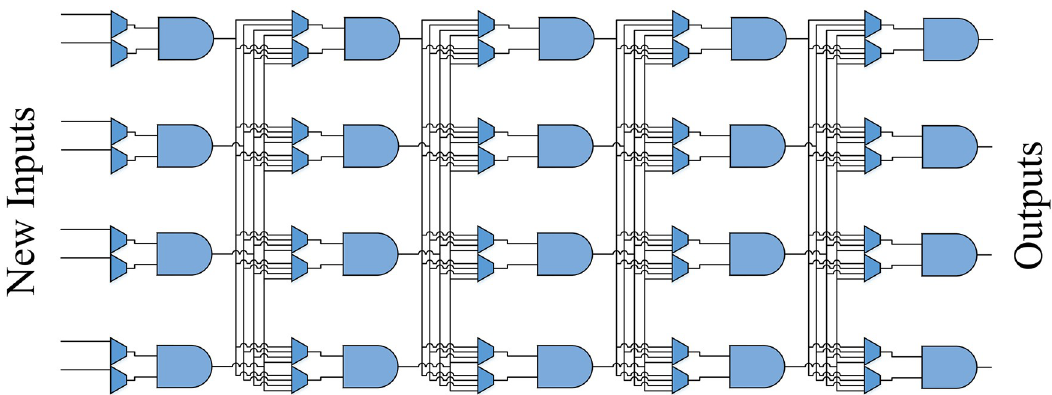
Fig 5. The unrolled architecture effectively equivalent to the case when the outputs of the fabricated circuit are fed back to the inputs five times.